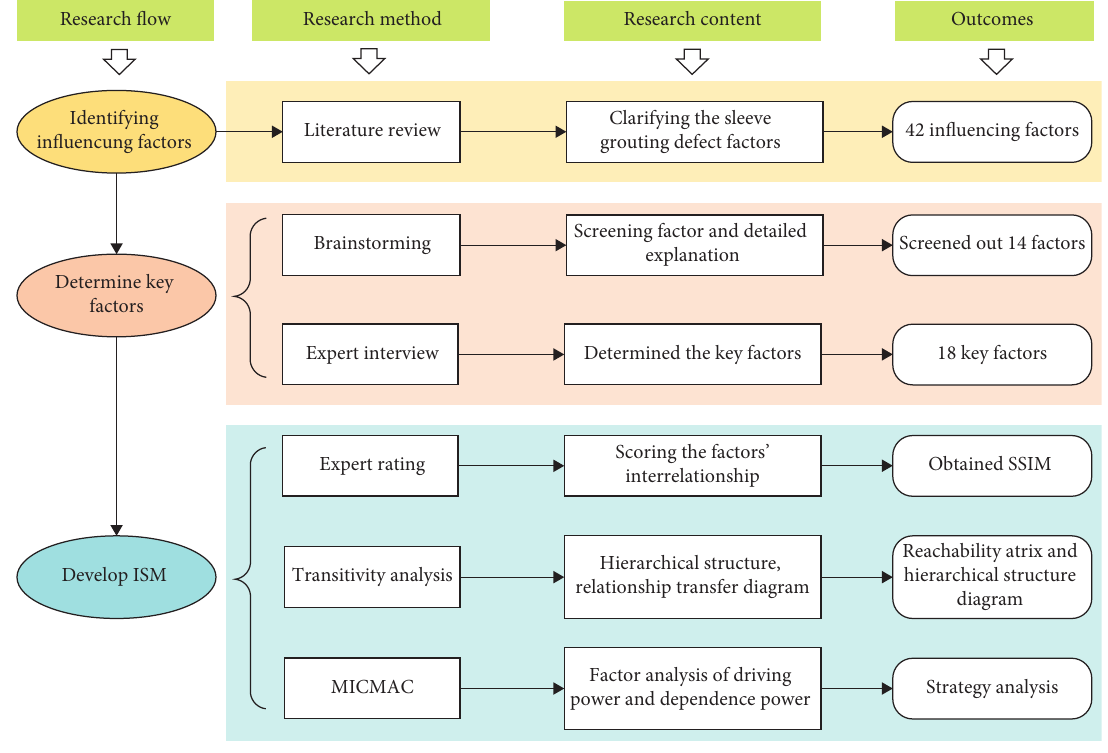
Figure 2: Research